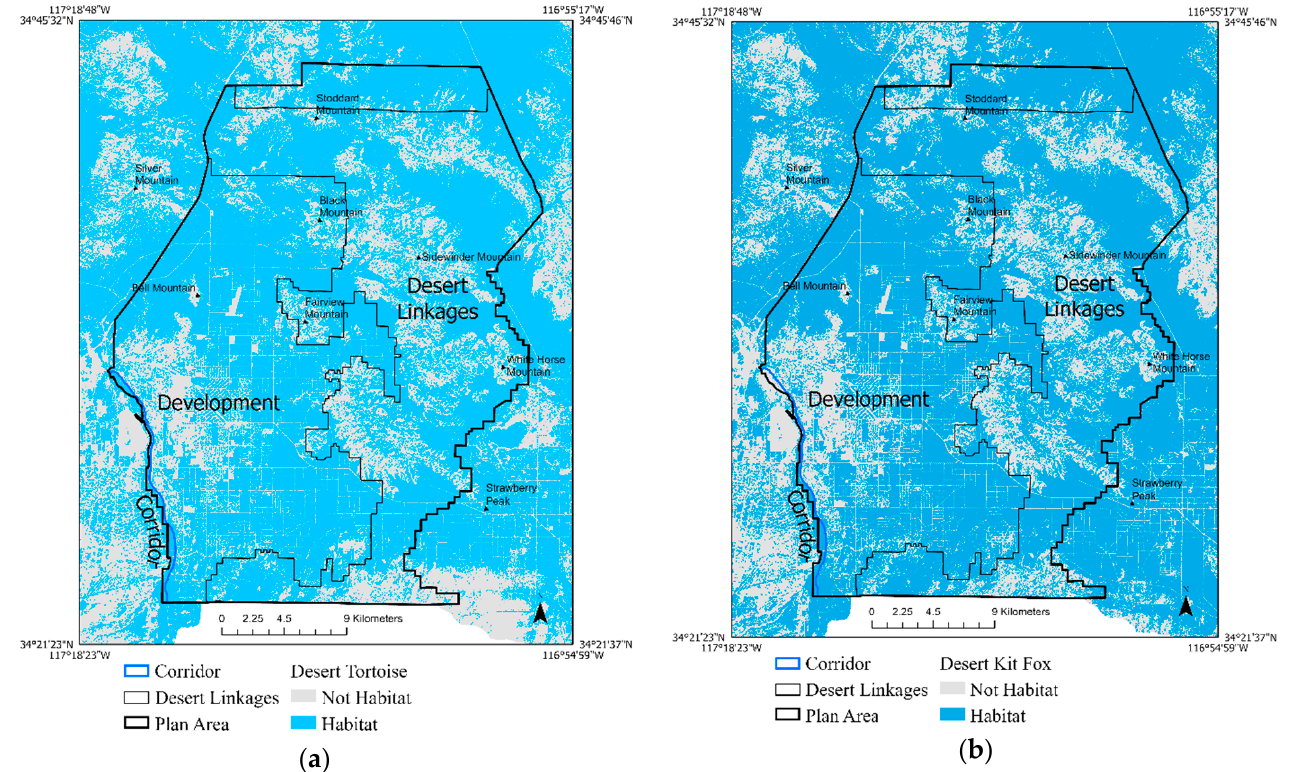
Figure 4. Desert tortoise habitat model ( a ) and desert kit fox habitat model ( b ) within the Apple Valley Multi-Species Habitat Conservation Plan area.